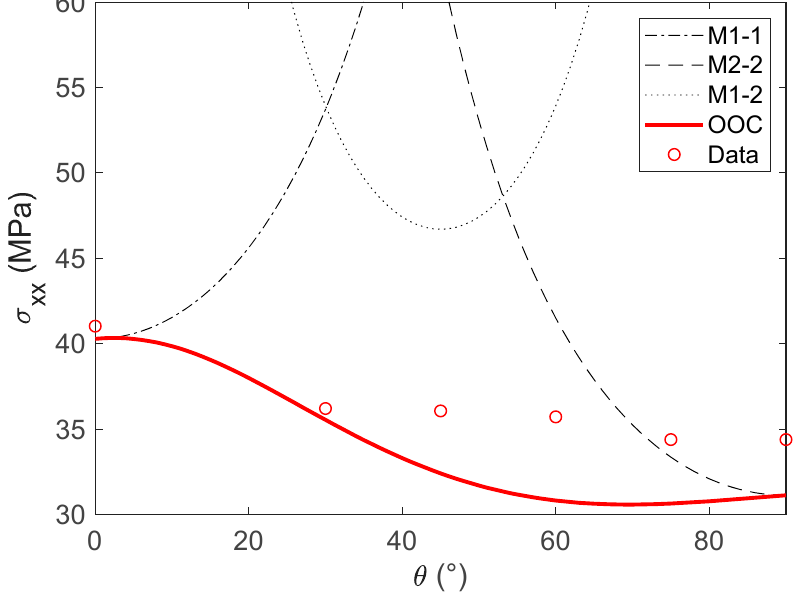
Figure 6. Comparison of Failure Criteria and experimental data.